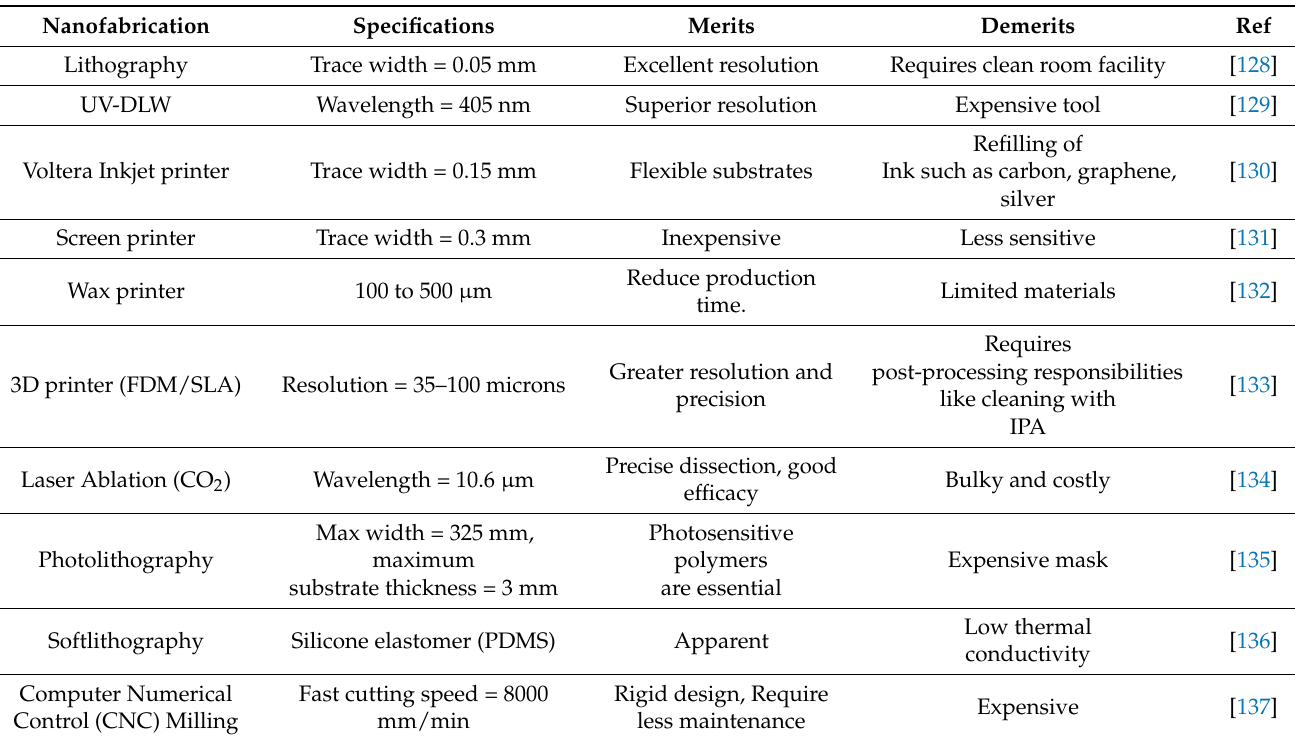
Table 6. Summaries of the several nanofabrication methods used in the development of